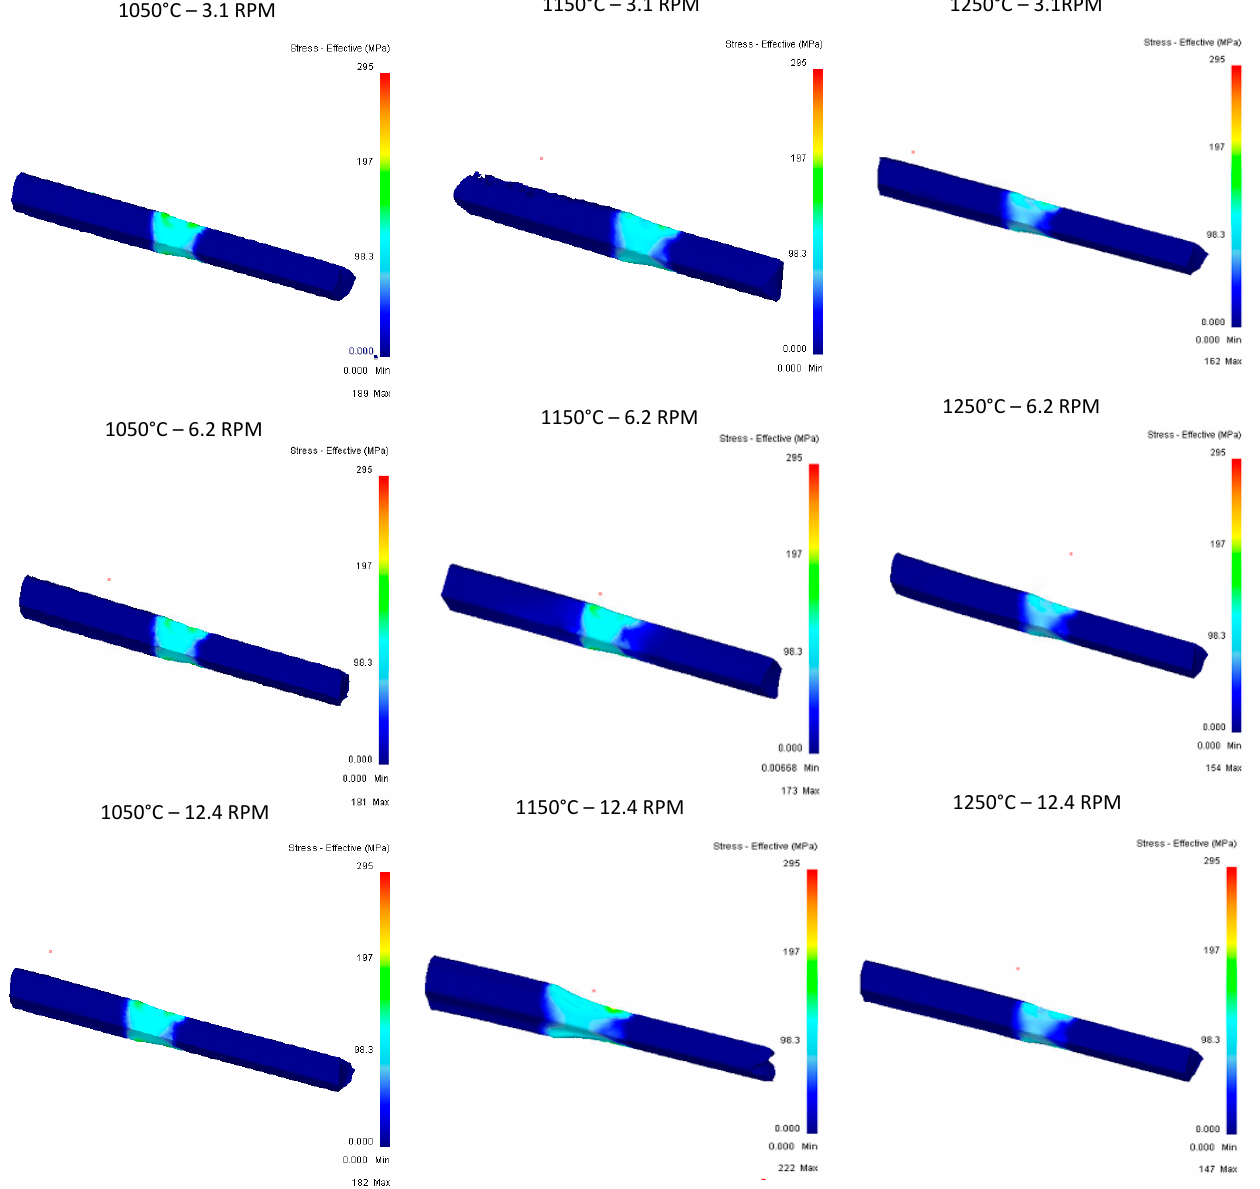
Figure 22. Effective stress in the top Rail after fifth pass. In Figure 23 show the effective stress due to the simulations of the 5th pass of the upper rail and, unlike the other simulations, here small concentrations in different parts of the rail depending on the run can be seen, appearing in the upper part (1150 °C-12.4 RPM) or lower part (1150 °C-6.2 RPM) depending on the observed case.